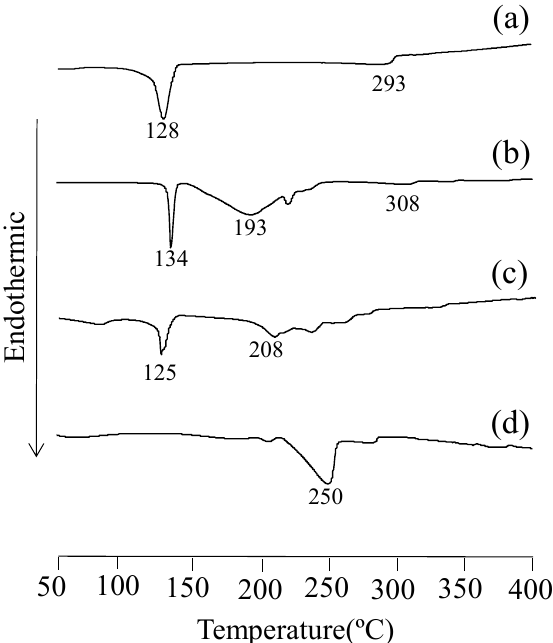
Figure 4. DSC curves of EA/UR systems. ( a ) EA; ( b ) UR; ( c ) PM (EA/UR = 1/1); and ( d ) EVP (EA/UR =